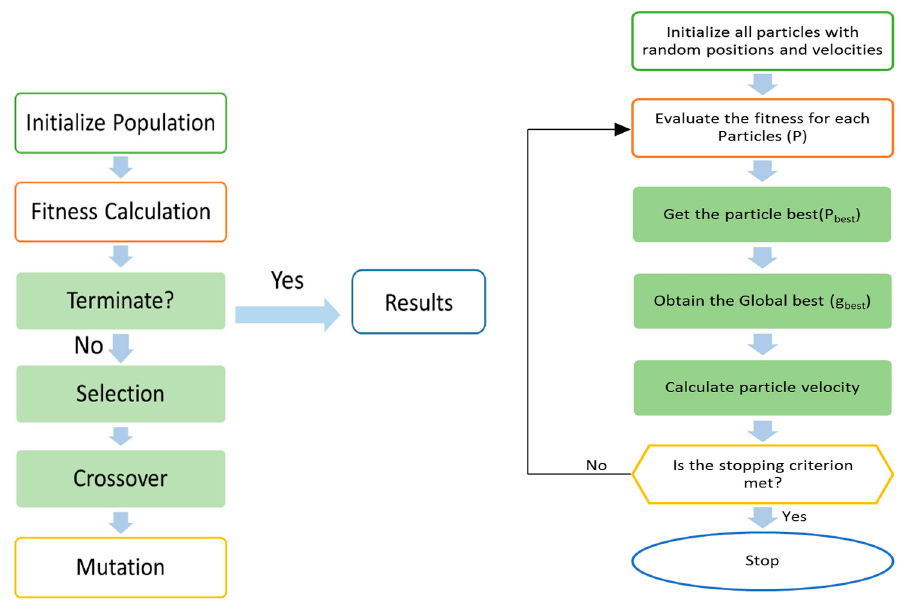
Figure 3. Flowchart of the genetic algorithm (left) and the particle swarm optimization algorithm (right).